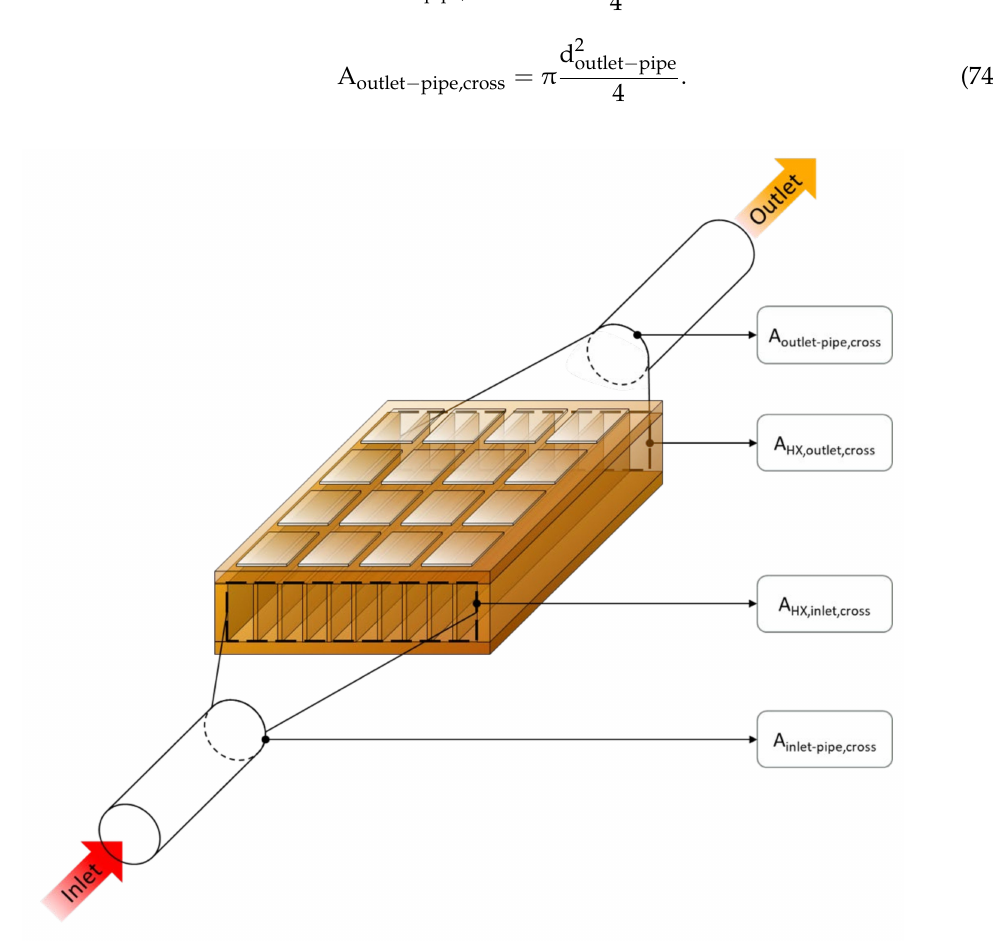
Figure 11. Areas used for calculating the pressure loss due to flow contraction and